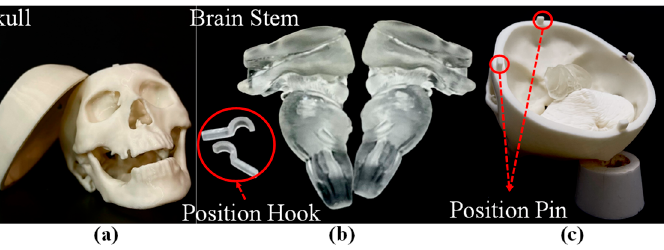
Figure 1. 3D-printed parts of medical simulator: ( a ) top and bottom of skull with position pins; ( b ) brain stem with position hooks; ( c ) assembled skull and brain stem.